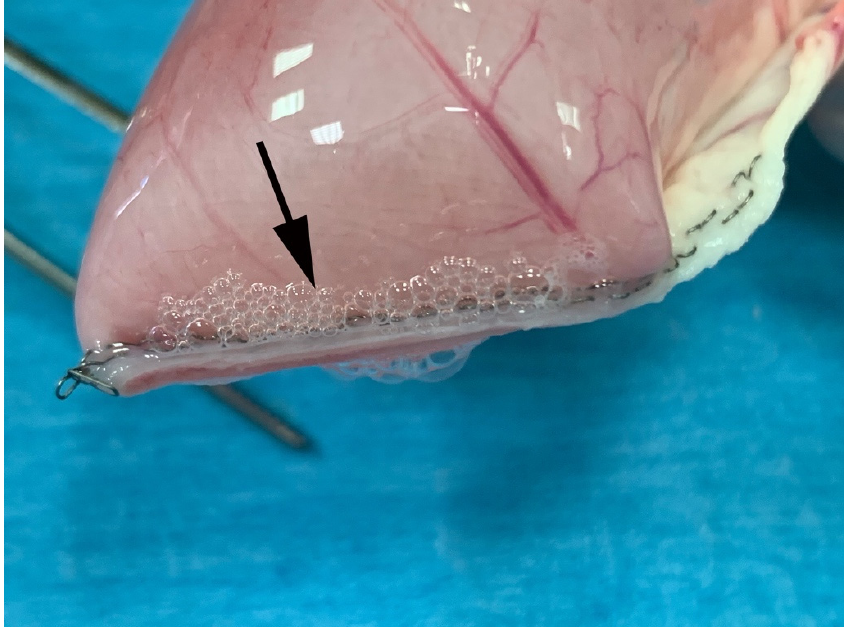
Figure 5. Representative image of Group S specimen during BP test. Air leaking was found at the staples site (black arrow). No failure of the construct was